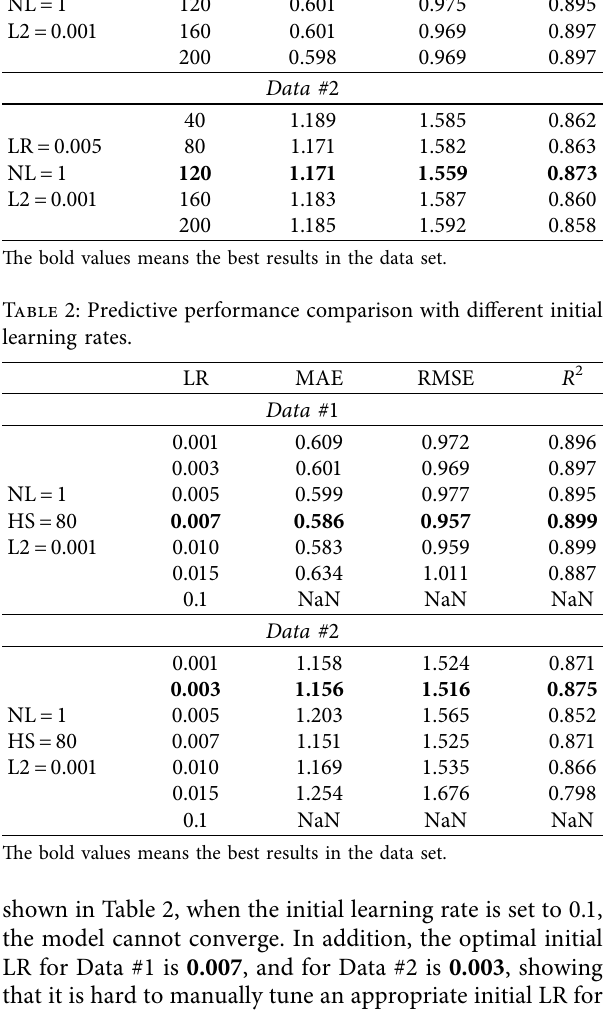
Table 1: Predictive performance comparison with diferent number of hidden units.